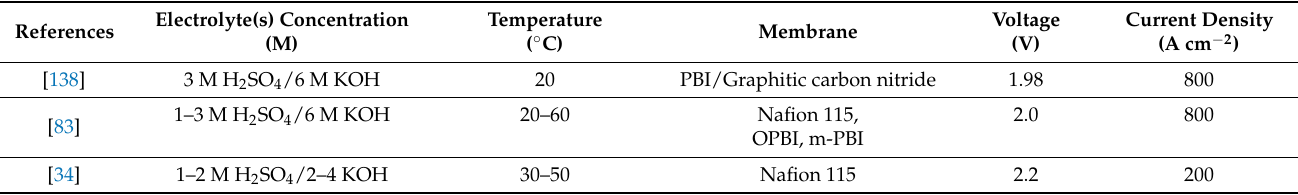
Table 5. Summary of acid-alkaline amphoteric electrolysis for hydrogen